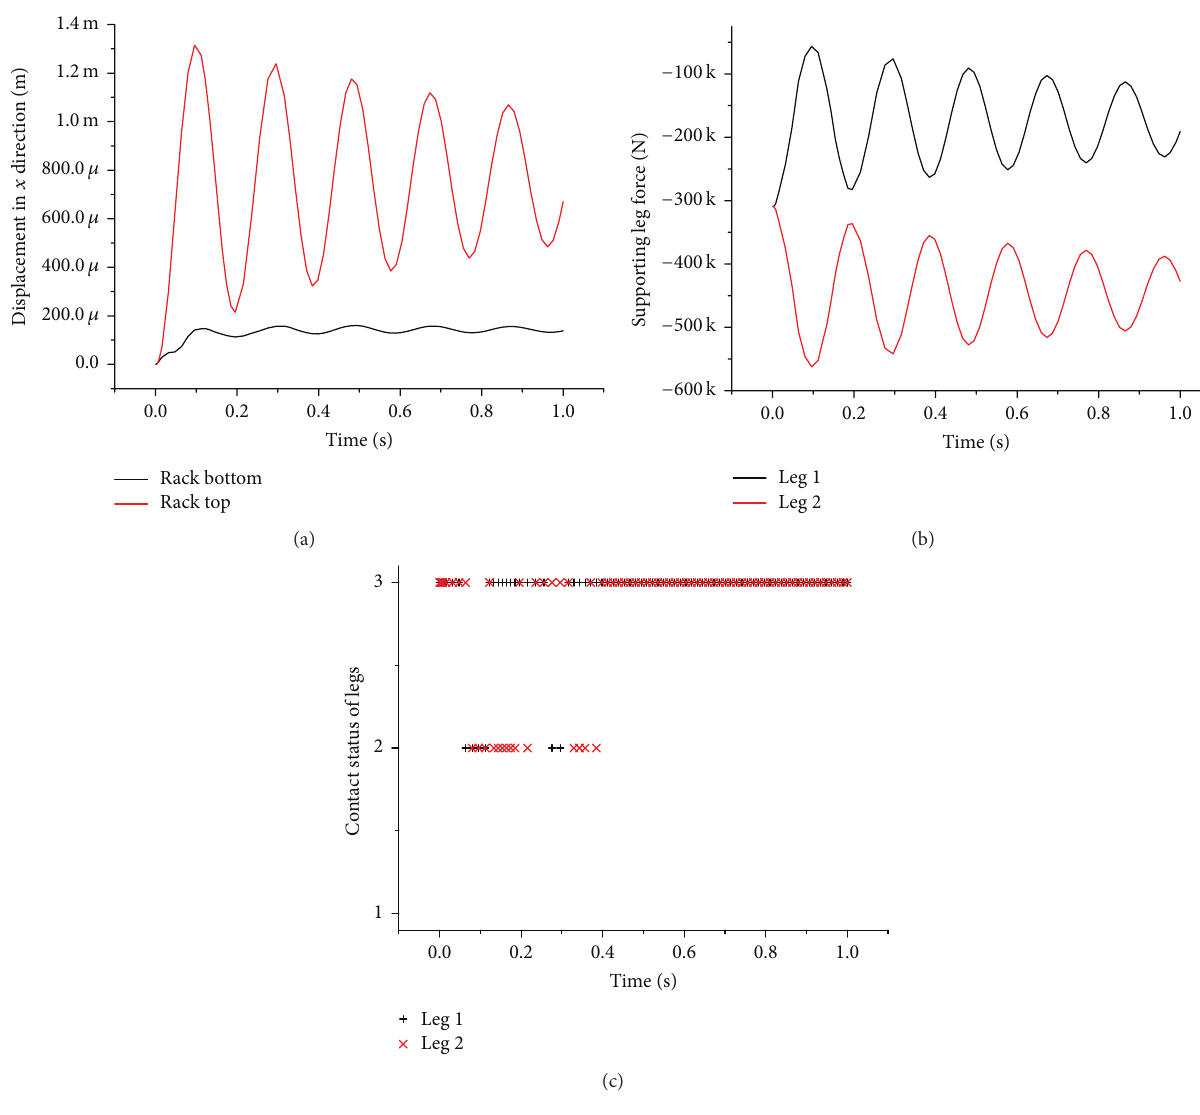
Figure 6: Uniform acceleration amplitude loading: 0.06